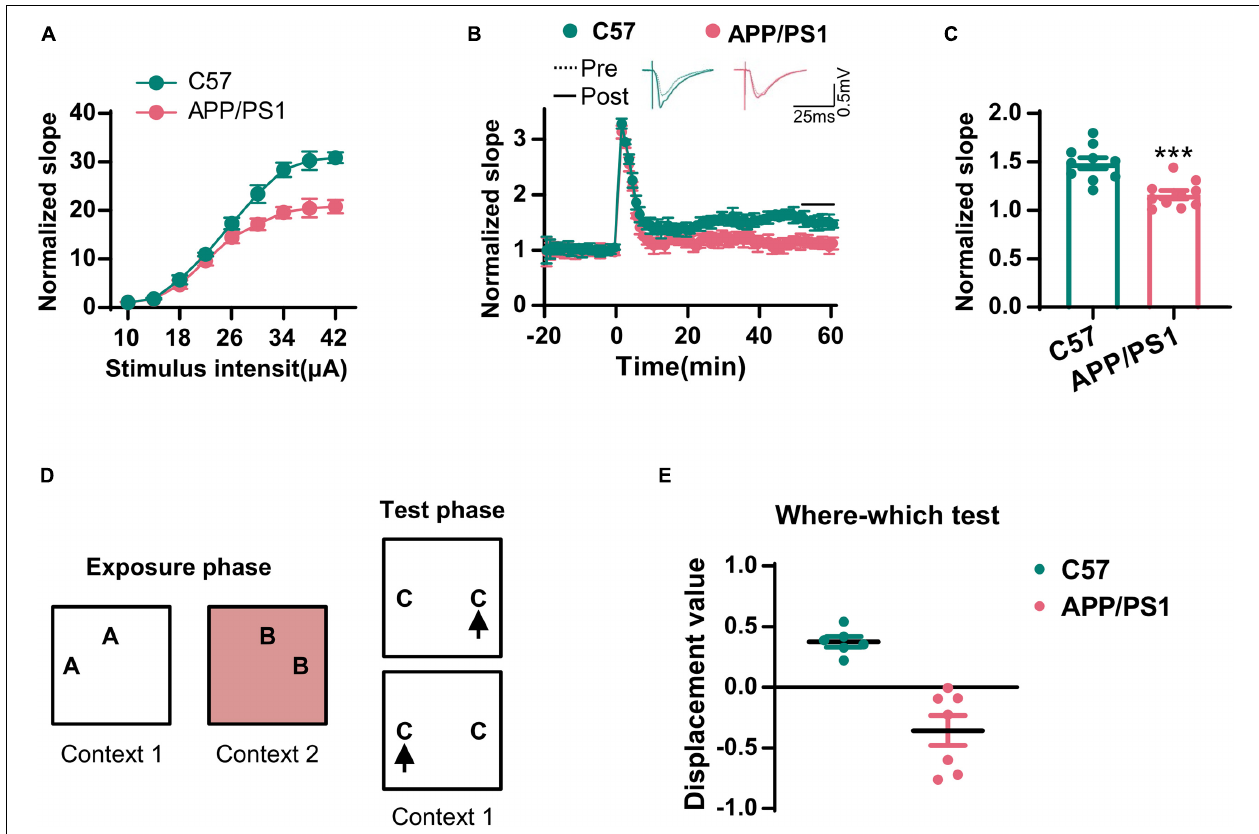
FIGURE 2 | The synaptic transmission and context–place memory were derogated in AD mice. (A) The input–output curve of the CA3–CA1 LTP was shown. (B) The electrophysiological recording to detect the fEPSP slope was used to evaluate the CA3–CA1 LTP. The representative fEPSP traces were shown in the upper panel, and the relative fEPSP slopes were shown in the lower panel. (C) The fEPSP slope of the last 5 min was statistically analyzed. Unpaired Student’s t -test; n = 10 slices from three mice for each group, *** p < 0.001. (D) A schematic diagram of the where–which test was used to examine the context–place memory. (E) The displacement value in the where–which test was evaluated. Unpaired Student’s t -test, n = 6–7 mice for each group, *** p < 0.001.